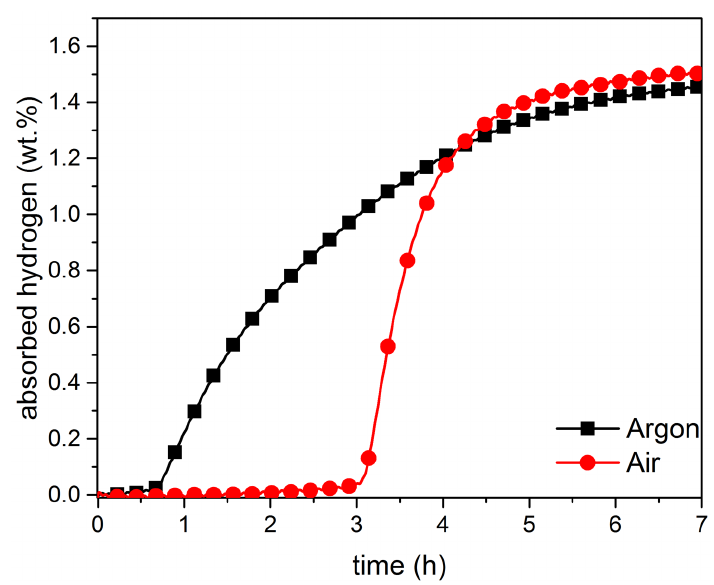
Figure 4. Activation curves of single-melt of TiFe + 4 wt.% Zr, under argon and under air, at room temperature. Applied hydrogen pressure is 4500 kPa.